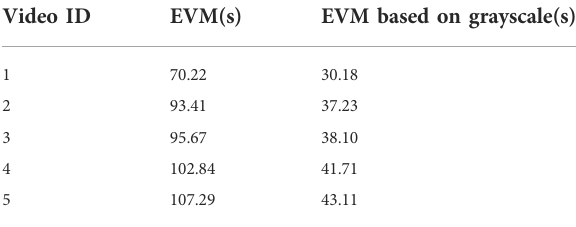
TABLE 5 EVM and EVM based grayscale processing